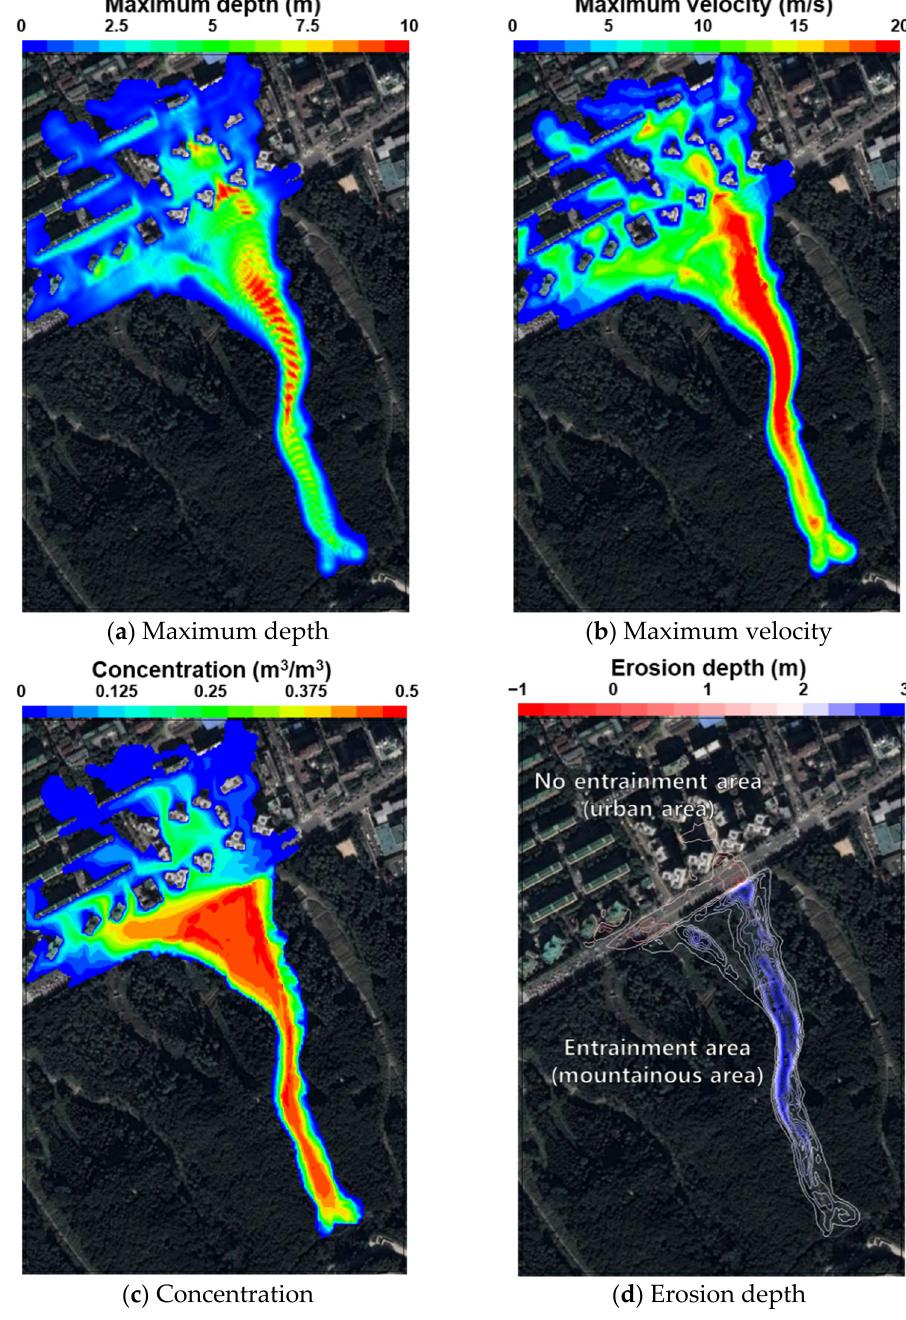
Figure 5. Final simulation result (Run2).